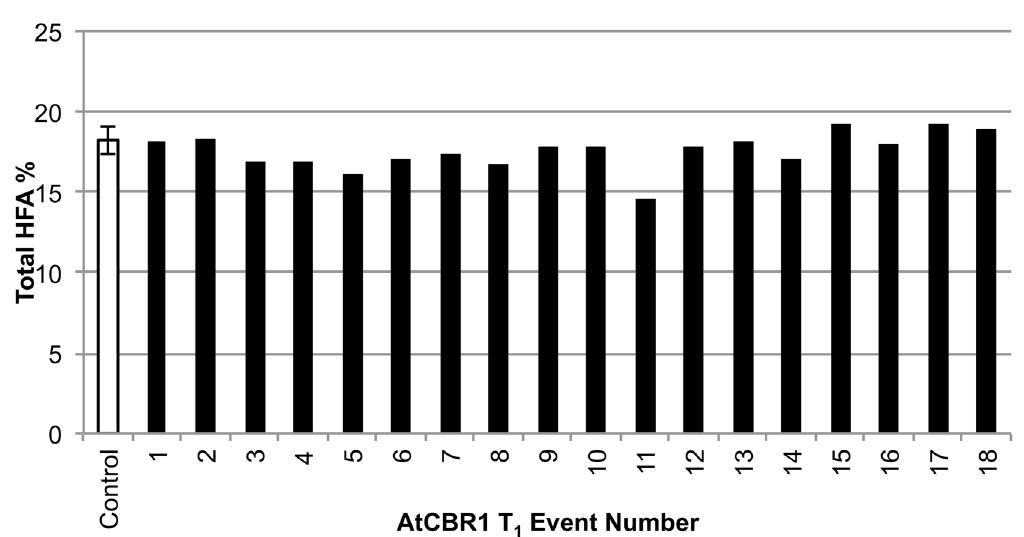
seeds of 2 plants. 1